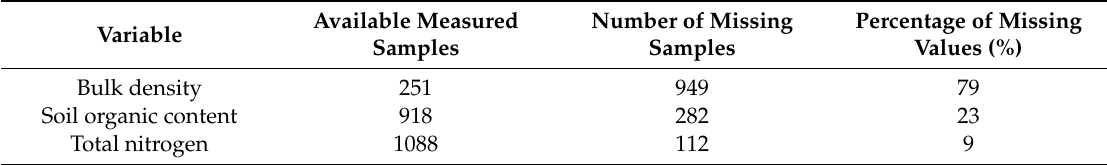
Table 1. Sample size and percentage of missing data for various soil health indicators in the Africa Soil Information Service (AfSIS) database version